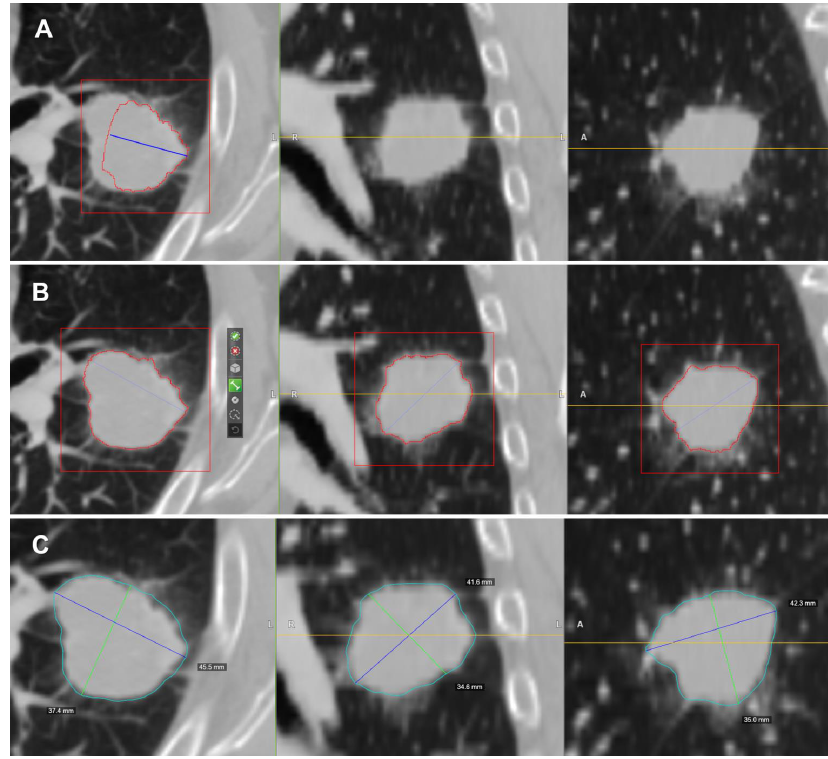
Figure 1. Semi-automatic lesion identification: ( A ) Manual ROI indication. In blue, it is possible to observe the axes that cross the lesion manually delineated by the radiologist on a plane of the MPR. The intensity of the lesion boundary (estimated) is represented with a red outline. ( B ) Additional axes can be dragged onto other orthogonal MPR views. From left to right, it is possible to observe the initial long axis outlined by the radiologist and the 2D contours on the axial, coronal and sagittal views of the lesion used as a starting point for the RPM ™ algorithms. ( C ) Resulting 3D contour of the lesion (in blue).